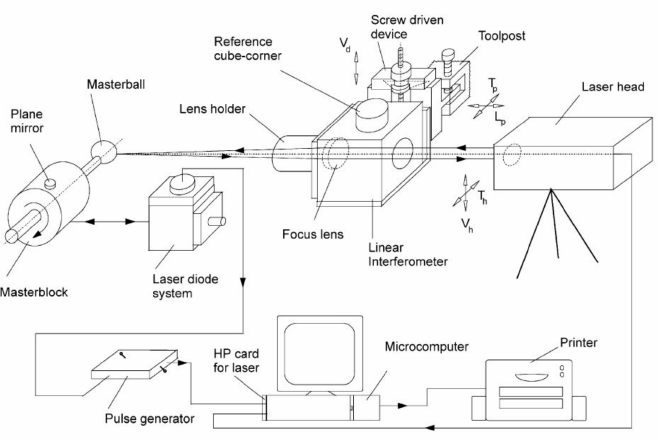
Figure 20. Setting the measuring set on the lathe [26].